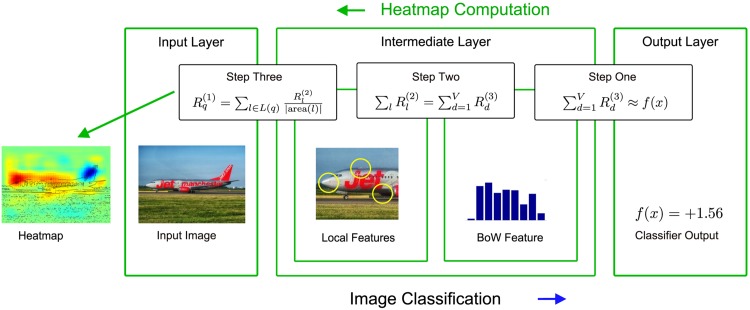
Local and global predictions for input images are obtained by following a series of steps through the classification- and pixel-wise decomposition pipelines.Each step taken towards the final pixel-wise decomposition has a complementing analogue within the Bag of Words classification pipeline. The calculations used during the pixel-wise decomposition process make use of information extracted by those corresponding analogues. Airplane image in the graphic by Pixabay user tpsdave.